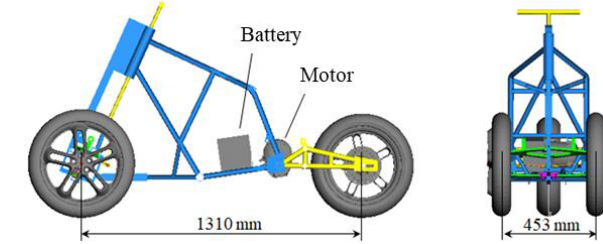
Figure 3. Geometric parameters of the